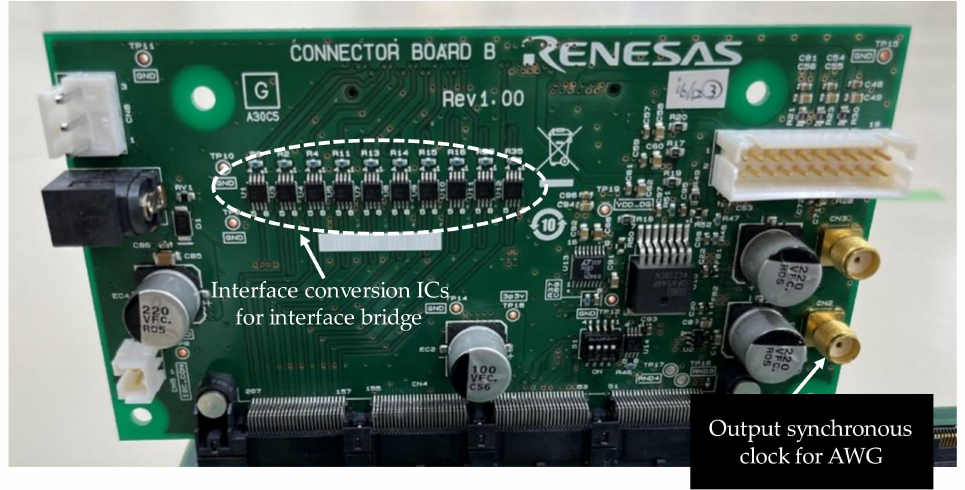
Figure 12. Connector board.